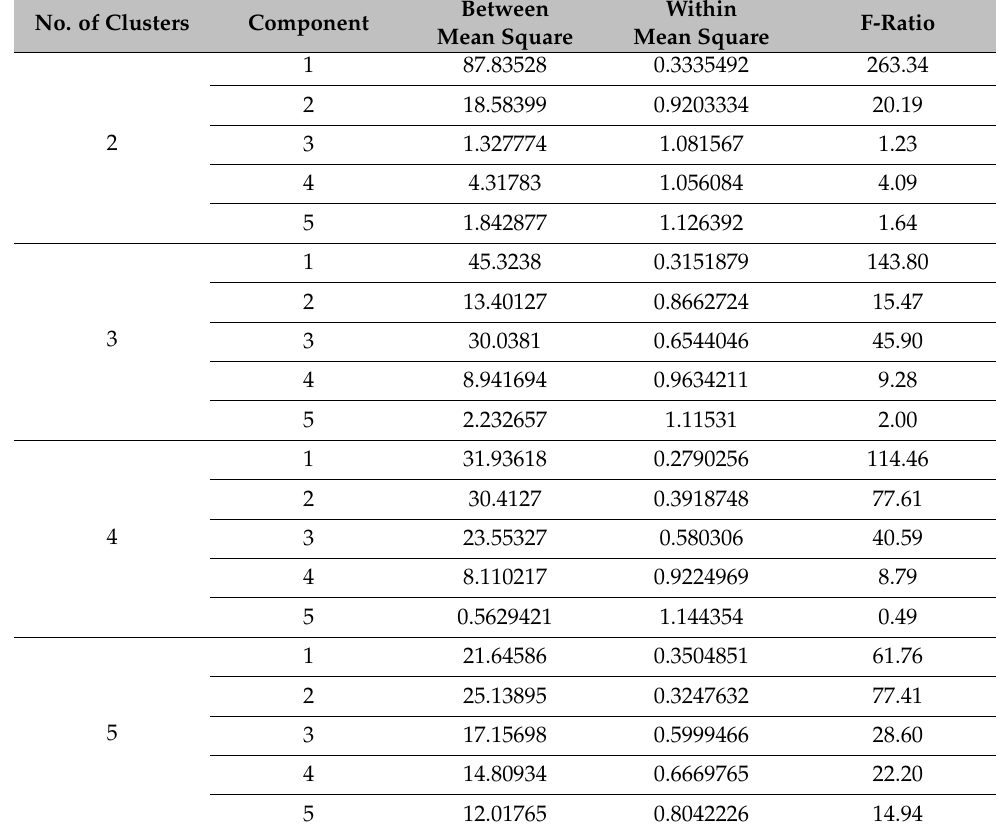
Table 4. K-means procedure performed on 2, 3, 4, and 5